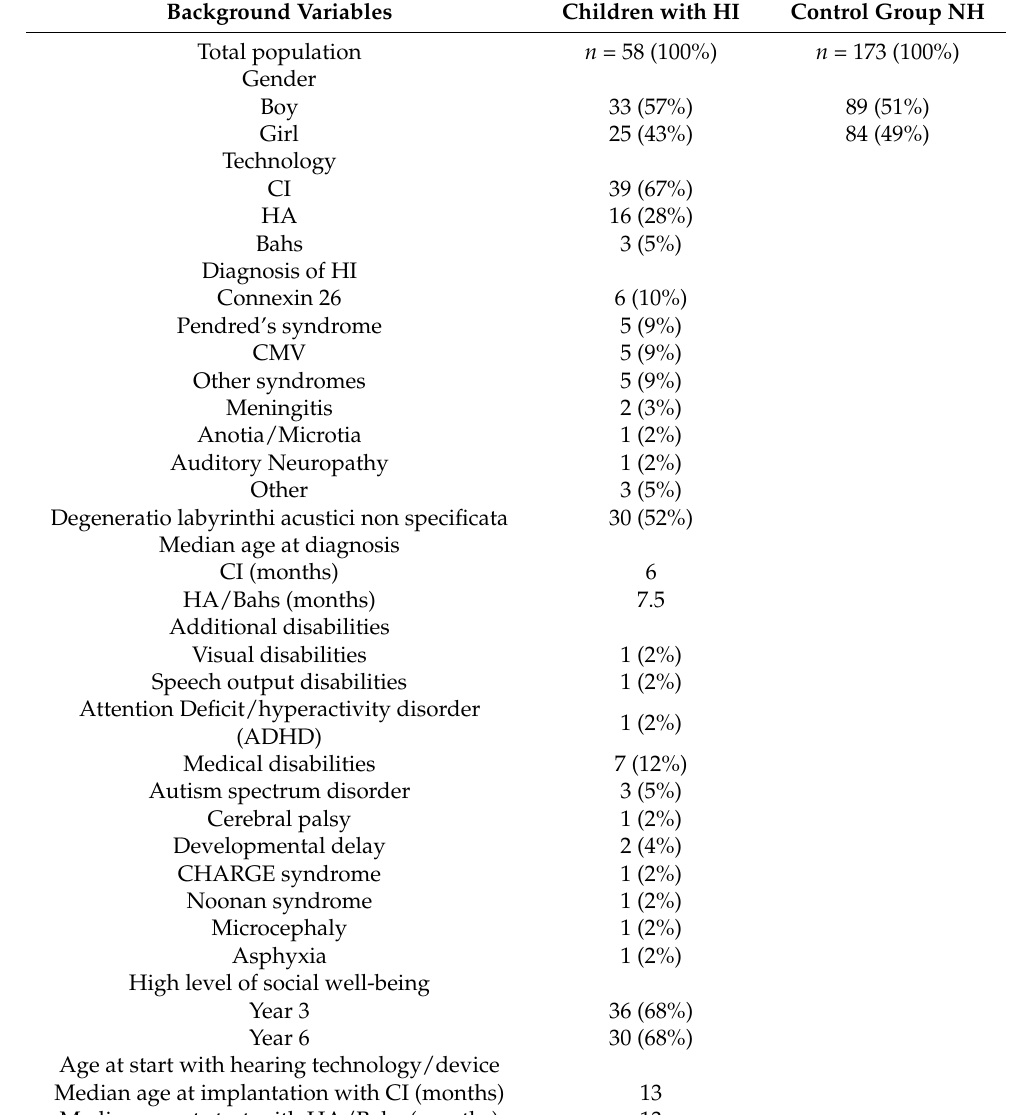
Table 1. Background variables for children with HI and